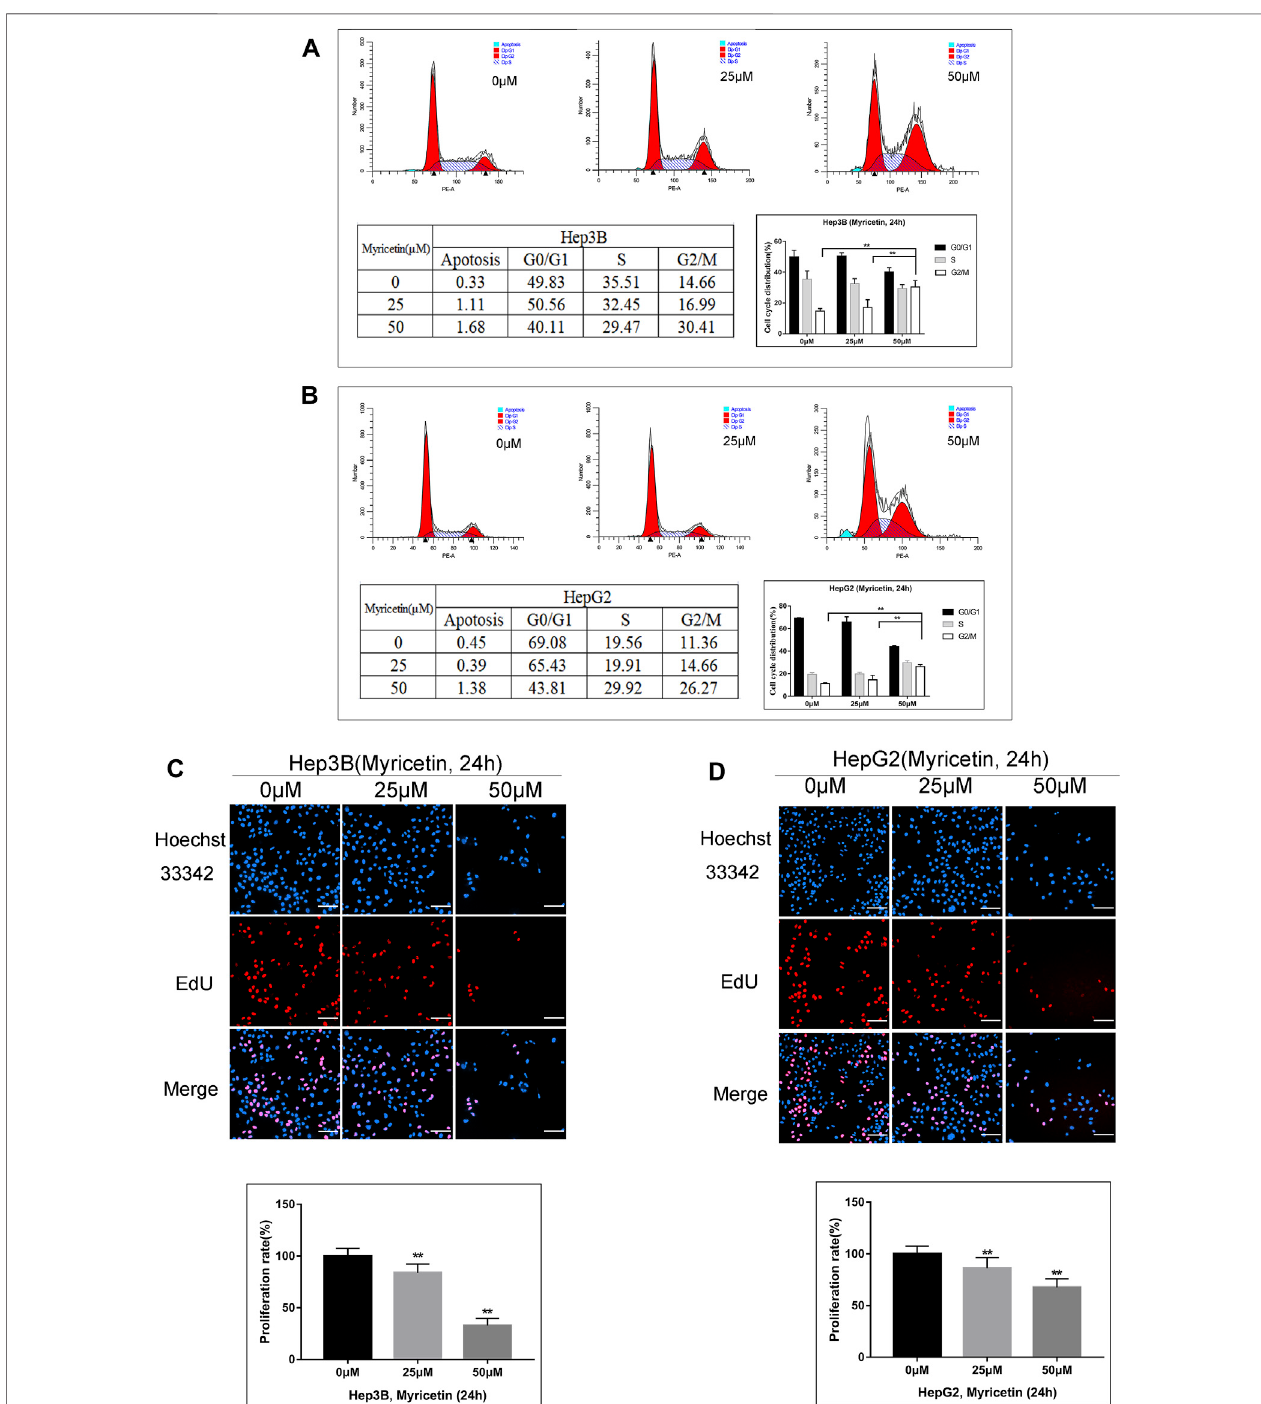
FIGURE4|MyricetinrepressesHCCproliferationandarrestscellcycleatG2/MphaseinHCCcells.(A) FlowcytometryoncellcycledistributionofHepG2cells treated with speci fi ed doses of myricetin for 24 h. (B) Cell cycle distribution of Hep3B cells. (C) The representative images showed the state of Hep3B cells proliferation with indicated does of myricetin treatment. Proliferation cells were stained with EdU (red), bar: 100 μ m. (D) The EdU assay was carried out to analyze proliferation of HepG2 cells treatedwithorwithoutmyricetin,bar:100 μ m.Alldataarefromresultsofthreeexperiments,presentedasthemeans ± SD.*represents p < 0.05,**represents p < 0.01. the expression of p-p38 MAPK and p-Stat3 is declined in HCC ( Figure 5A ). To identify whether MARCH1 is involved in the cells with myricetin treatment ( Figure 5A ), and cell cycle proteins regulation of p38 MAPK and Stat3 signaling pathways by Bcl-2, CyclinB1, and CyclinD1 are also signi fi cantly reduced myricetin, MARCH1 was knocked down by siRNAs in HCC